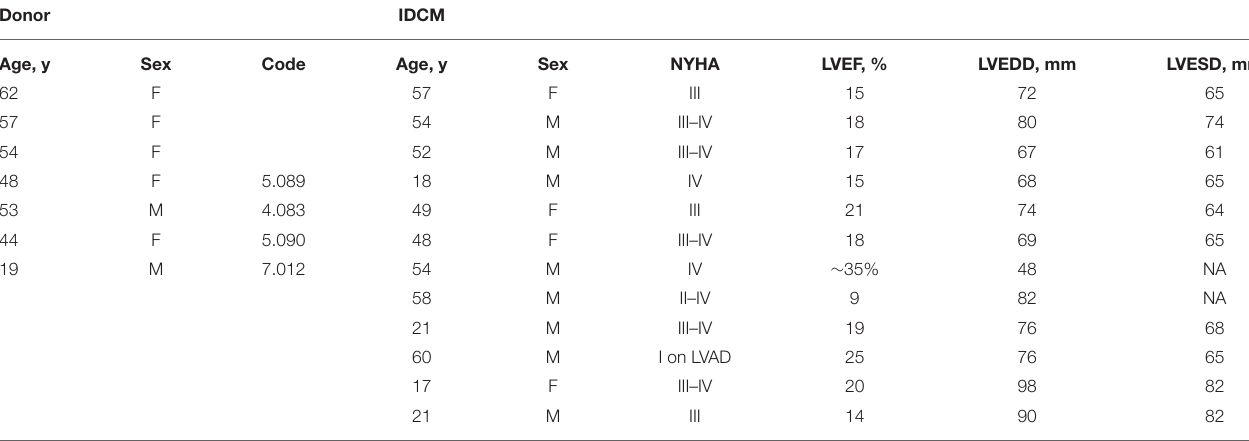
TABLE 1 | Donor and patient